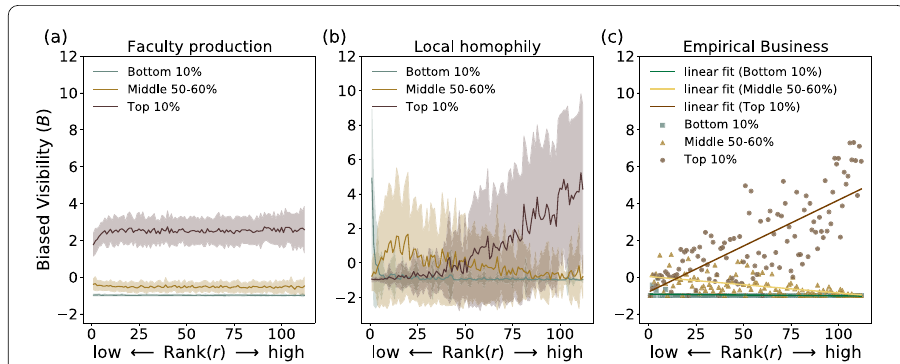
Figure 4 Biased visibility B for three groups of institutions (top 10%, middle 50–60%, and bottom 10%) as a function of perceiver institution’s rank r for two models and the empirical Business network. ( a ) The Faculty production model, ( b ) Local homophily model, and ( c ) the empirical Business hiring network where each point is a department and lines indicate the best linear fit to the corresponding data. All models are from skewed initialization. Solid lines in ( a ), ( b ) denote the average over 50 networks ensembles, and the shaded region indicates the standard